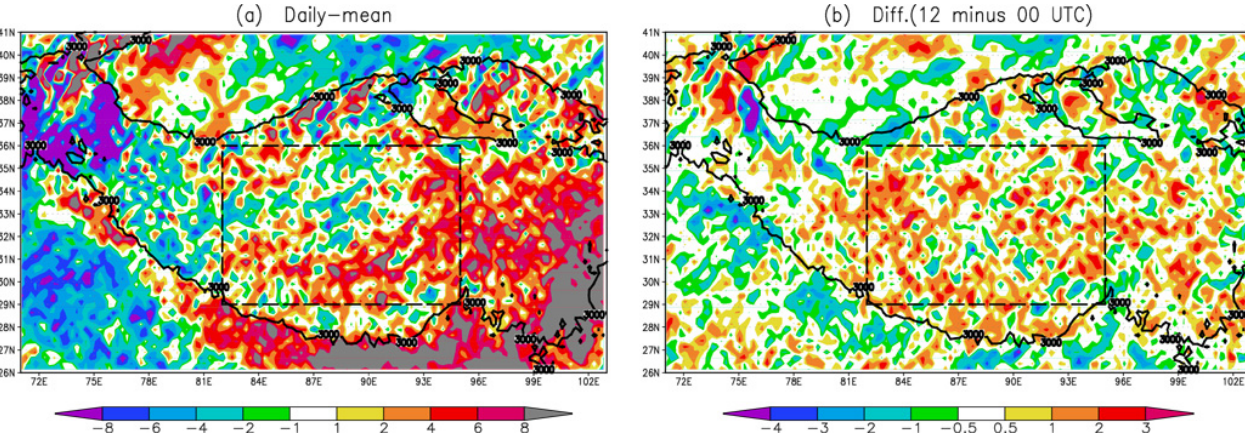
Fig. 6. 250hPa divergence: (a) daily mean ( × 10 − 6 s − 1 ) , (b) difference ( × 10 − 5 s − 1 ) between 12:00 and 00:00UTC. Solid lines indicate the 3000m topography. The dashed rectangles represent the central